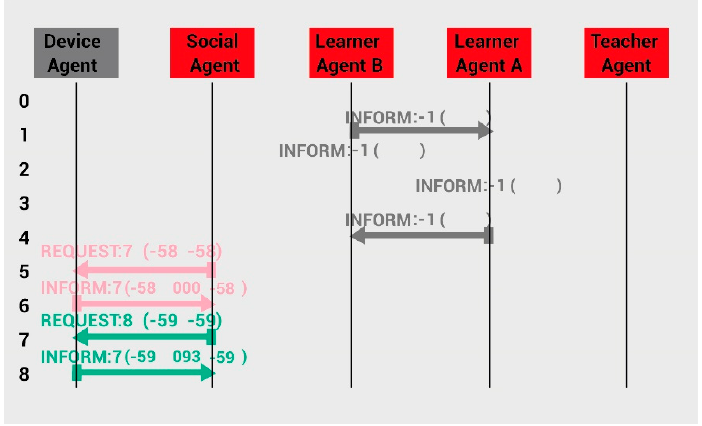
Figure 20. Simulation of interactions between teacher agents and other agents.